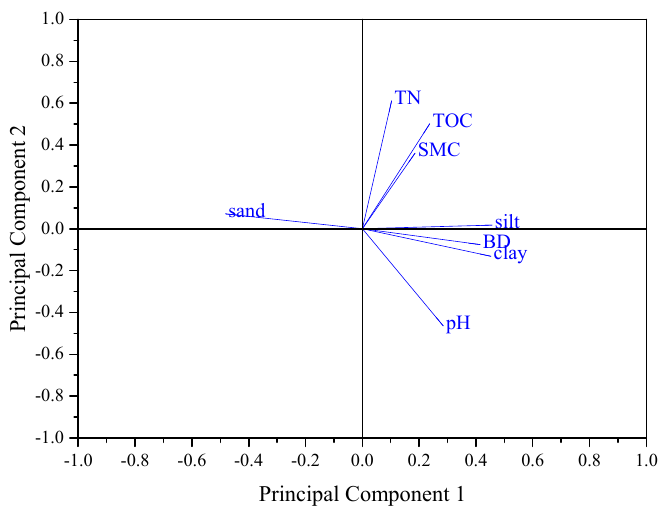
Figure 8. Principal component analysis showing two components associated with sediment C and N pools.